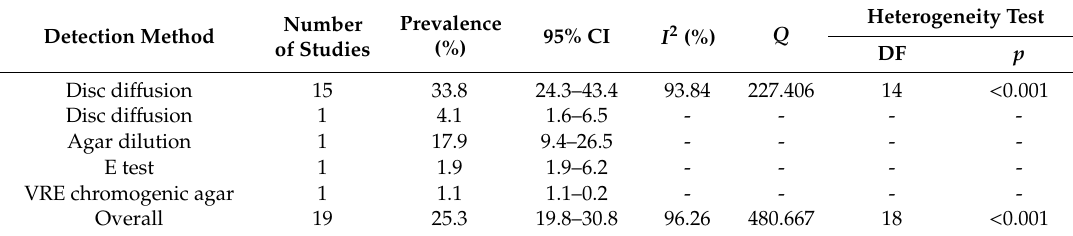
Table 5. Subgroup analysis for comparison of prevalence of VRE using various detection methods. Detection